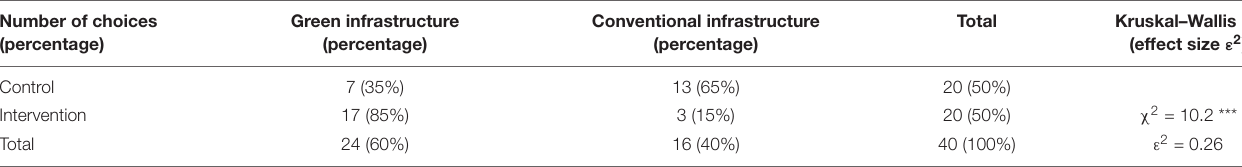
Conventional infrastructure (percentage)